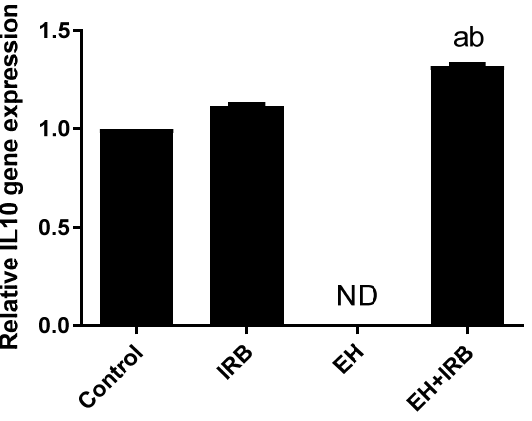
Figure 5. Uterine interleukin-10 (IL10) relative gene expression detected by real-time polymerase chain reaction. Values represent the mean ± SEM ( n = 6) a,b Significantly different ( p < 0.05) from control and EH groups, respectively. IRB: irbesartan; ND: non-detected.